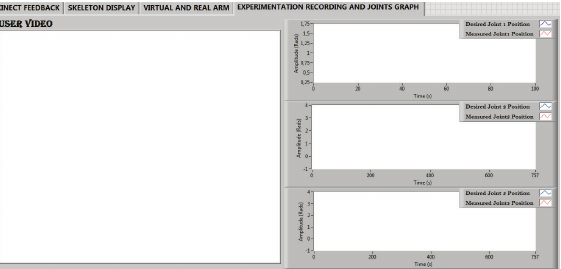
Figure 5: System overview.